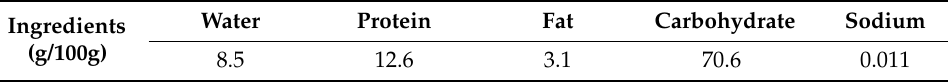
Table 1. Proximate composition of native oat